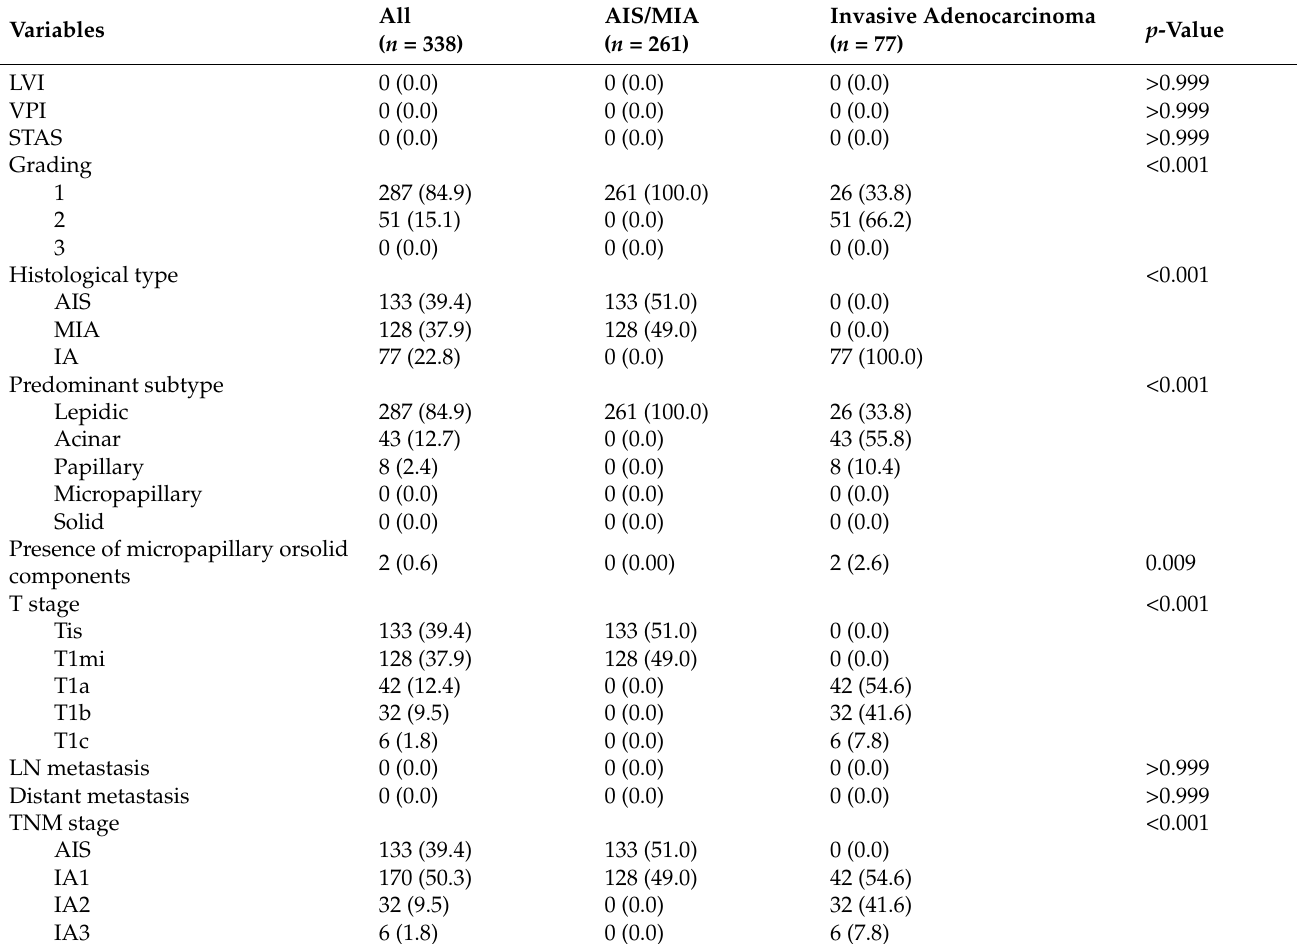
Table 2. Pathological